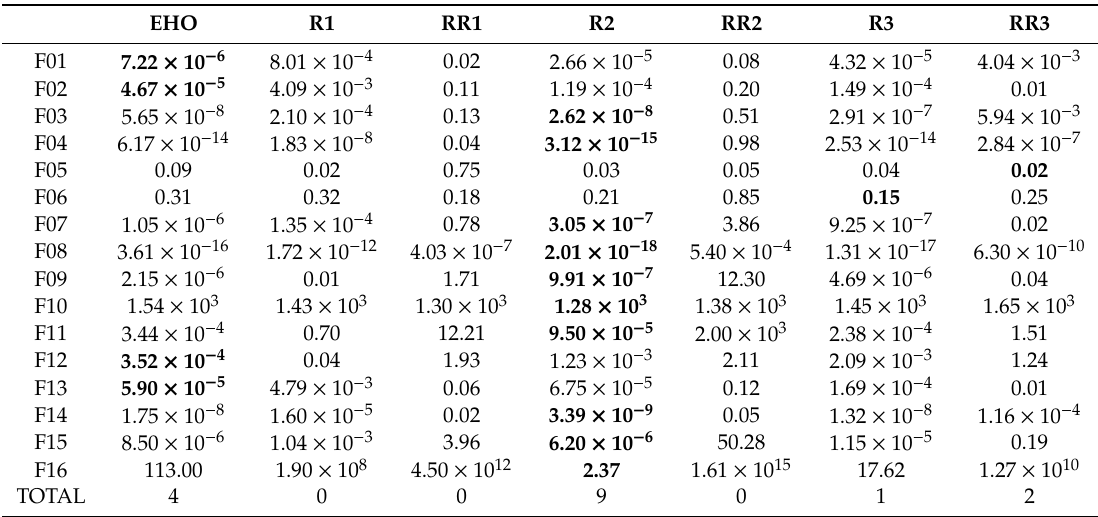
Table 9. Standard function values obtained by EHO and six improved methods with D =